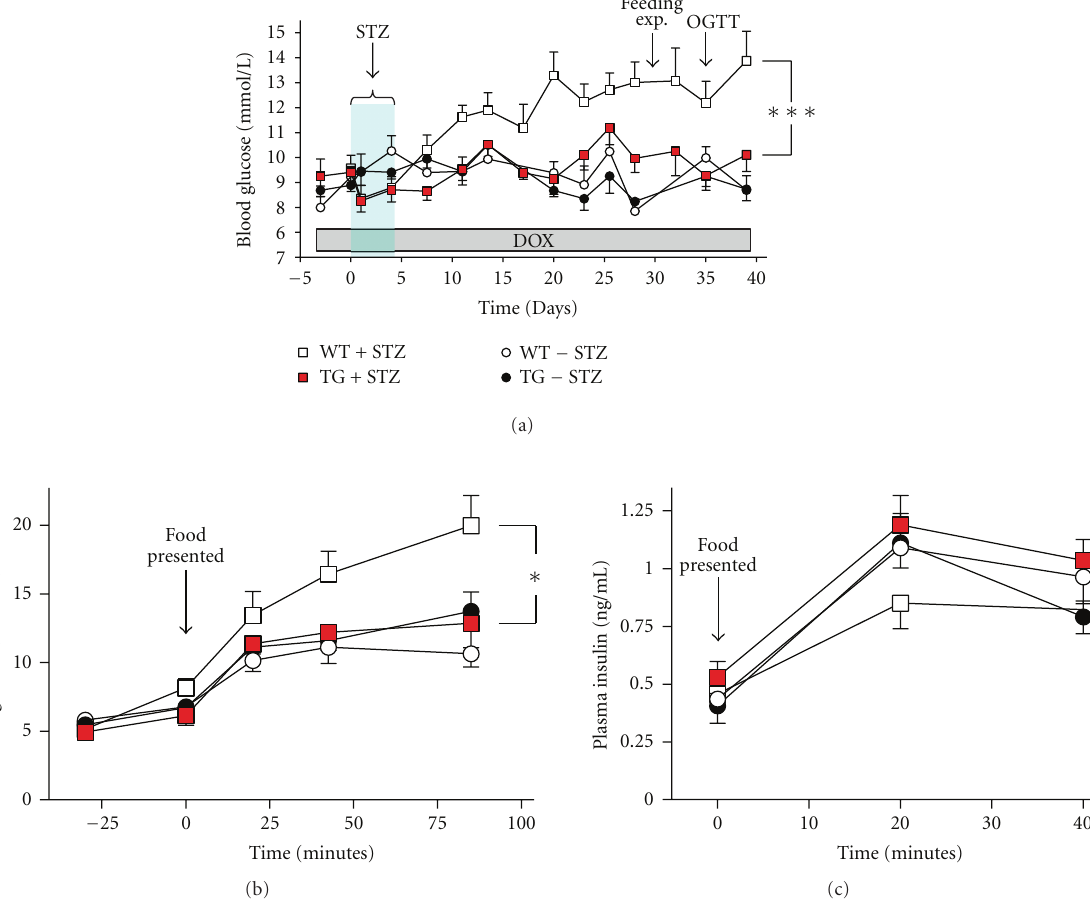
Figure 2: Protection against STZ-induced hyperglycemia by β -cell specific overexpression of GPR39 in the tetGPR39/RIP-rtTA mice. (a) Nonfasting blood glucose levels measured twice a week. DOX was given in the drinking water to all four groups of animals from day 3. A group of tetGPR39/RIP-rtTA transgenic mice (TG + STZ (red square), n = 11) and a group of wild-type littermates (WT + STZ (open square), n = 11) were treated with low-dose STZ injections, 40mg/kg daily from day 0 to day 4. A group of tetGPR39/RIP-rtTA transgenic mice (TG − STZ (black circles), n = 7) and a group of wild-type littermates (WT − STZ (open circles), n = 6), were mock treated with vehicle injections from day 0 to day 4. (b, c) At day 28, all animals were fasted for 18 hours before given access to food at time 0: the blood glucose (b) and insulin (c) were monitored at times indicated. ∗ P < 0 . 05, ∗∗∗ P < 0 . 001 (repeated measures (mixed model) ANOVA performed on WT + STZ versus TG +